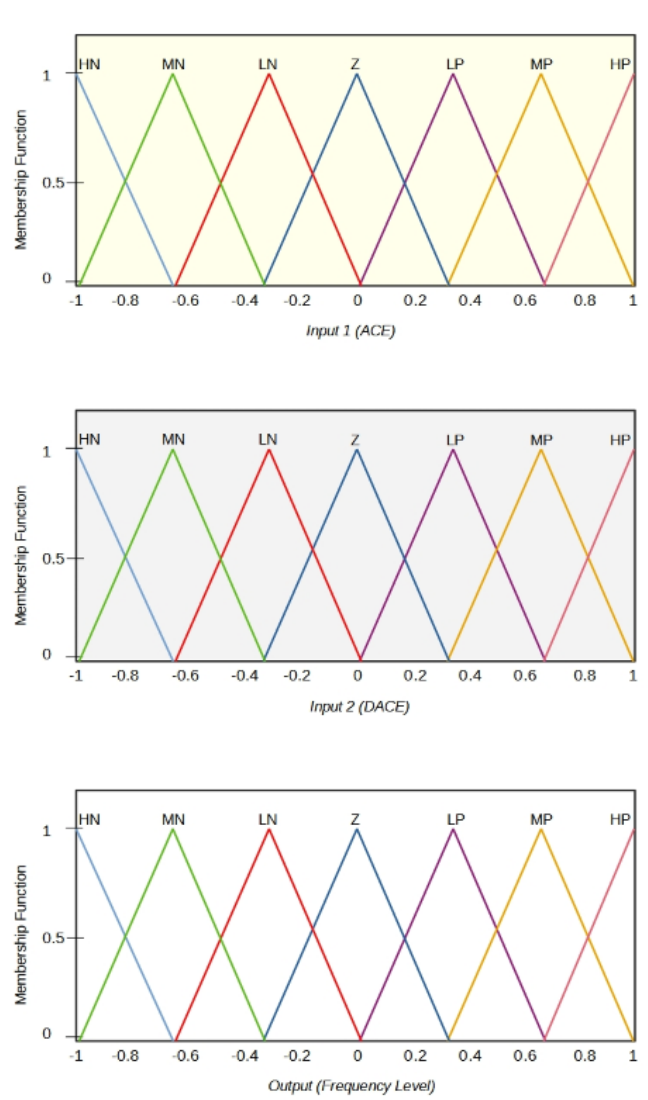
Figure 6. Membership functions of fuzzy logic.